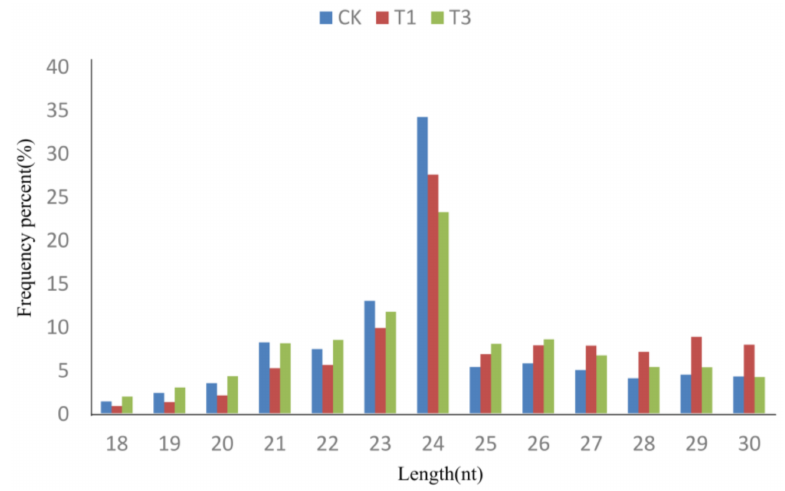
Figure 2. Length distribution of small RNAs in three samples. Y-axis: the percentage of small RNA reads. Table 2. Known miRNA families and their transcript abundance in the three